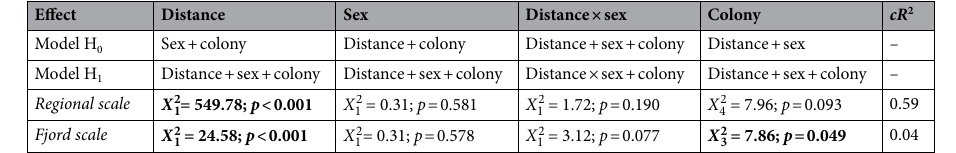
Table 3. Binomial generalized linear mixed models testing the effect of colony, distance, sex (female as reference level) and their interaction on the use of glacier fronts by black-legged kittiwakes at two different scales: (1) Regional scale , based on all glacier fronts occurring in a radius of 50 km from Kongsfjorden’s centroid and (2) Fjord scale , based on all glacier fronts occurring in Kongsfjorden, Svalbard. Colony was included as a fixed effect to account for their average difference in glacier front use. The individual ID was fitted as random effects. Likelihood ratio Chi-squared statistic and associated p values are given, with models specifying the null (H 0 ) and alternative (H 1 ) hypotheses specified for each test. cR 2 is the conditional R 2 (i.e., for both fixed and random effects ) for the model using the distance, sex and colony as additive fixed predictors. Significance (shown in bold) based on the nominal threshold of 0.05